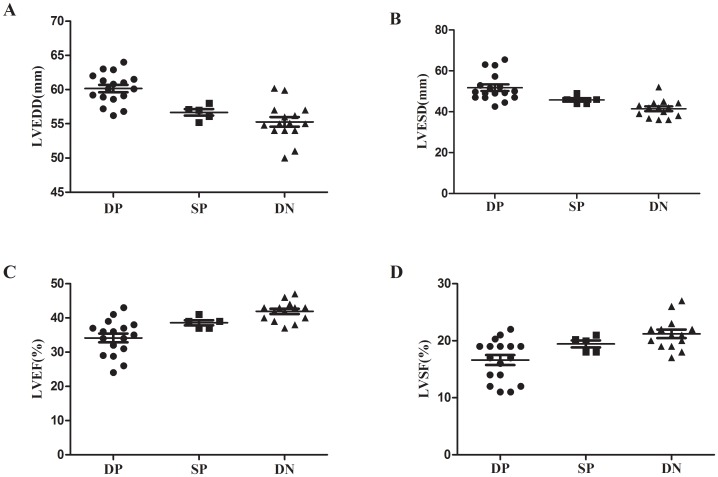
The comparison of echocardiographic data from patients with different positive autoantibodies.Echocardiographic data among patients with double positive (DP) autoantibodies, single positive autoantibodies (SP) and double negative (DN) autoantibodies had significant difference: LVEDD and LVESD: DP>SP>DN (P = 0.001), LVEF and LVSF: DP<SP<DN (P<0.01).